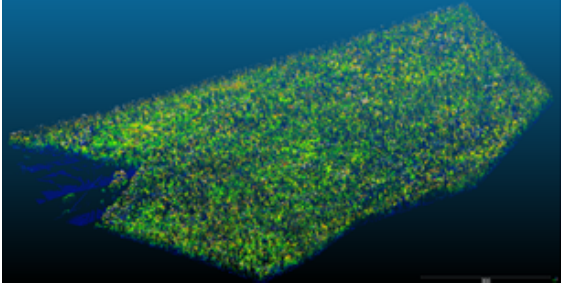
Figure 15: Elevated surface fuel at 0.40m resolution Figure 15 shows the elevated surface fuel visualised using CloudCompare at resolution 0.40m and Figure 16 shows the vegetation in the near-surface fuel level across the entire site.